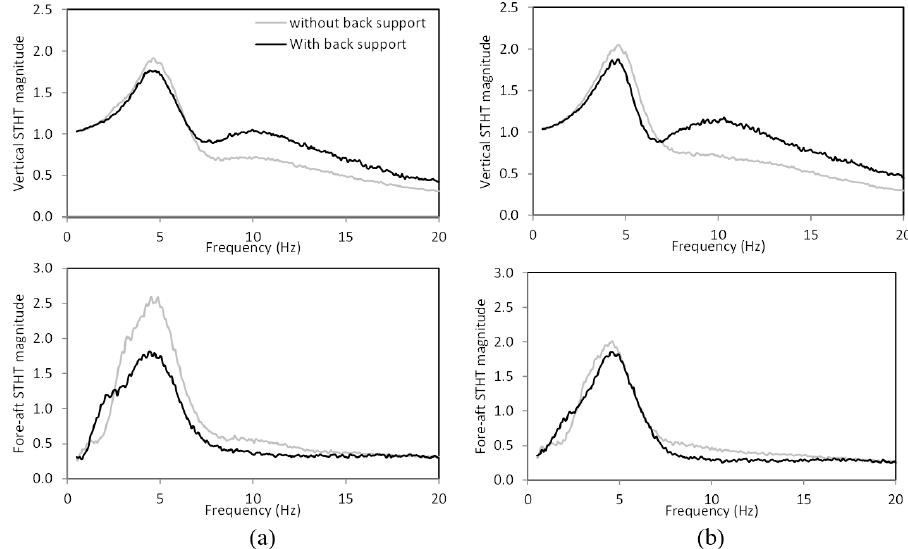
Figure 5. Comparisons of the mean STHT magnitudes of 31 male and 27 female subjects seated with and without back support under 0.50 m/s 2 excitations: ( a ) male subjects; and ( b ) female